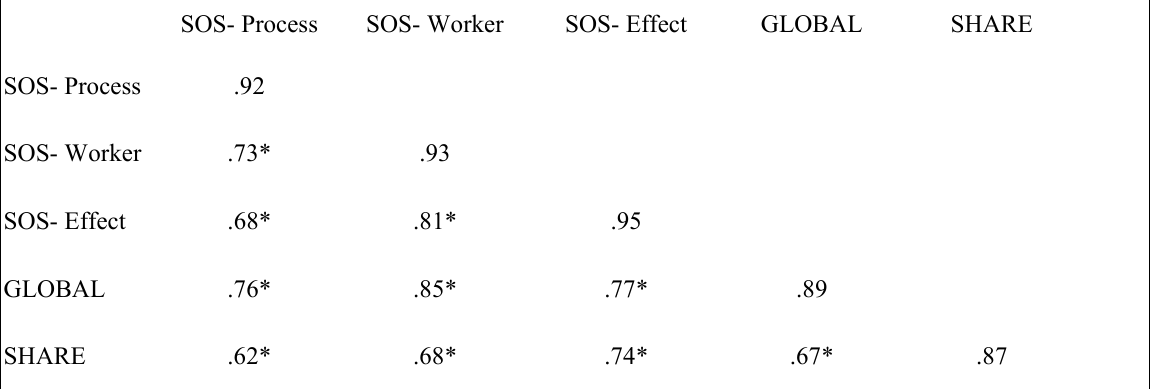
Correlations between the various measures of subjective outcome evaluation SOS- Process SOS- Worker SOS- Effect